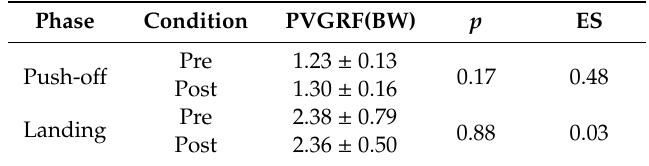
Table 4. Peak value of vertical ground reaction forces (GRF) in the push-o ff phase and landing